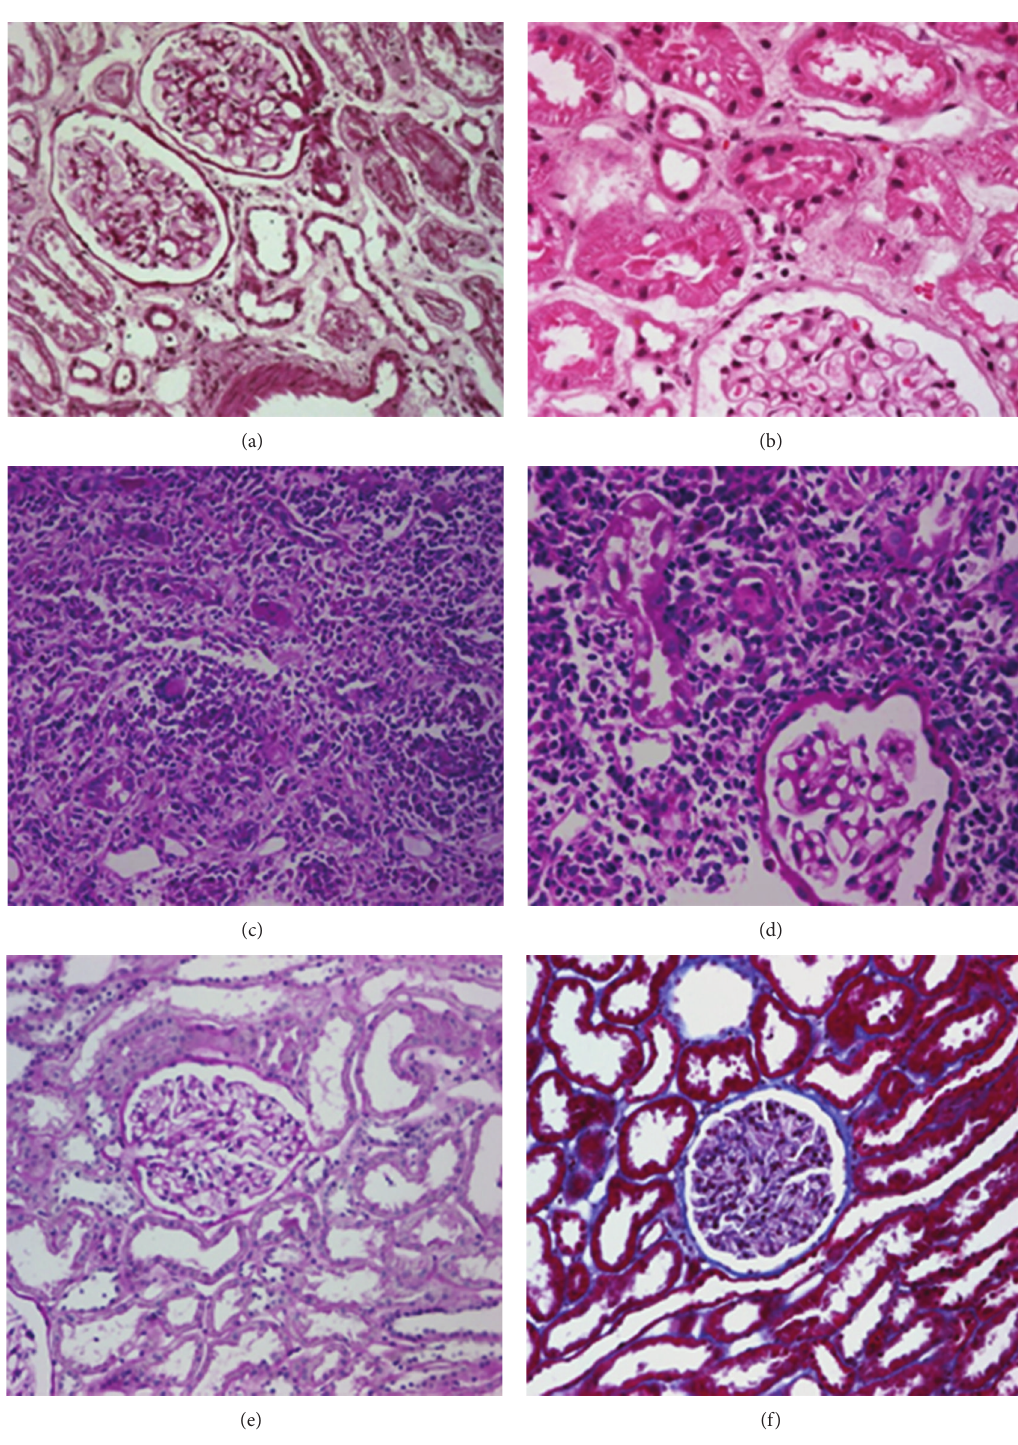
Figure 1: Renal graft biopsies. In case 1, histological findings were irrelevant; no viral inclusions were identified by light microscopy (H&E (a) and (b)) or immunohistochemistry. Renal biopsy of case 2 demonstrated focal interstitial necrotizing granulomata with neutrophils, plasma cells, and lymphocytes ((c) H&E and (d) PAS stain); note that the glomeruli are not affected. Control graft biopsy only demonstrated minimal interstitial fibrosis ((e) PAS stain and (f) Masson trichromic